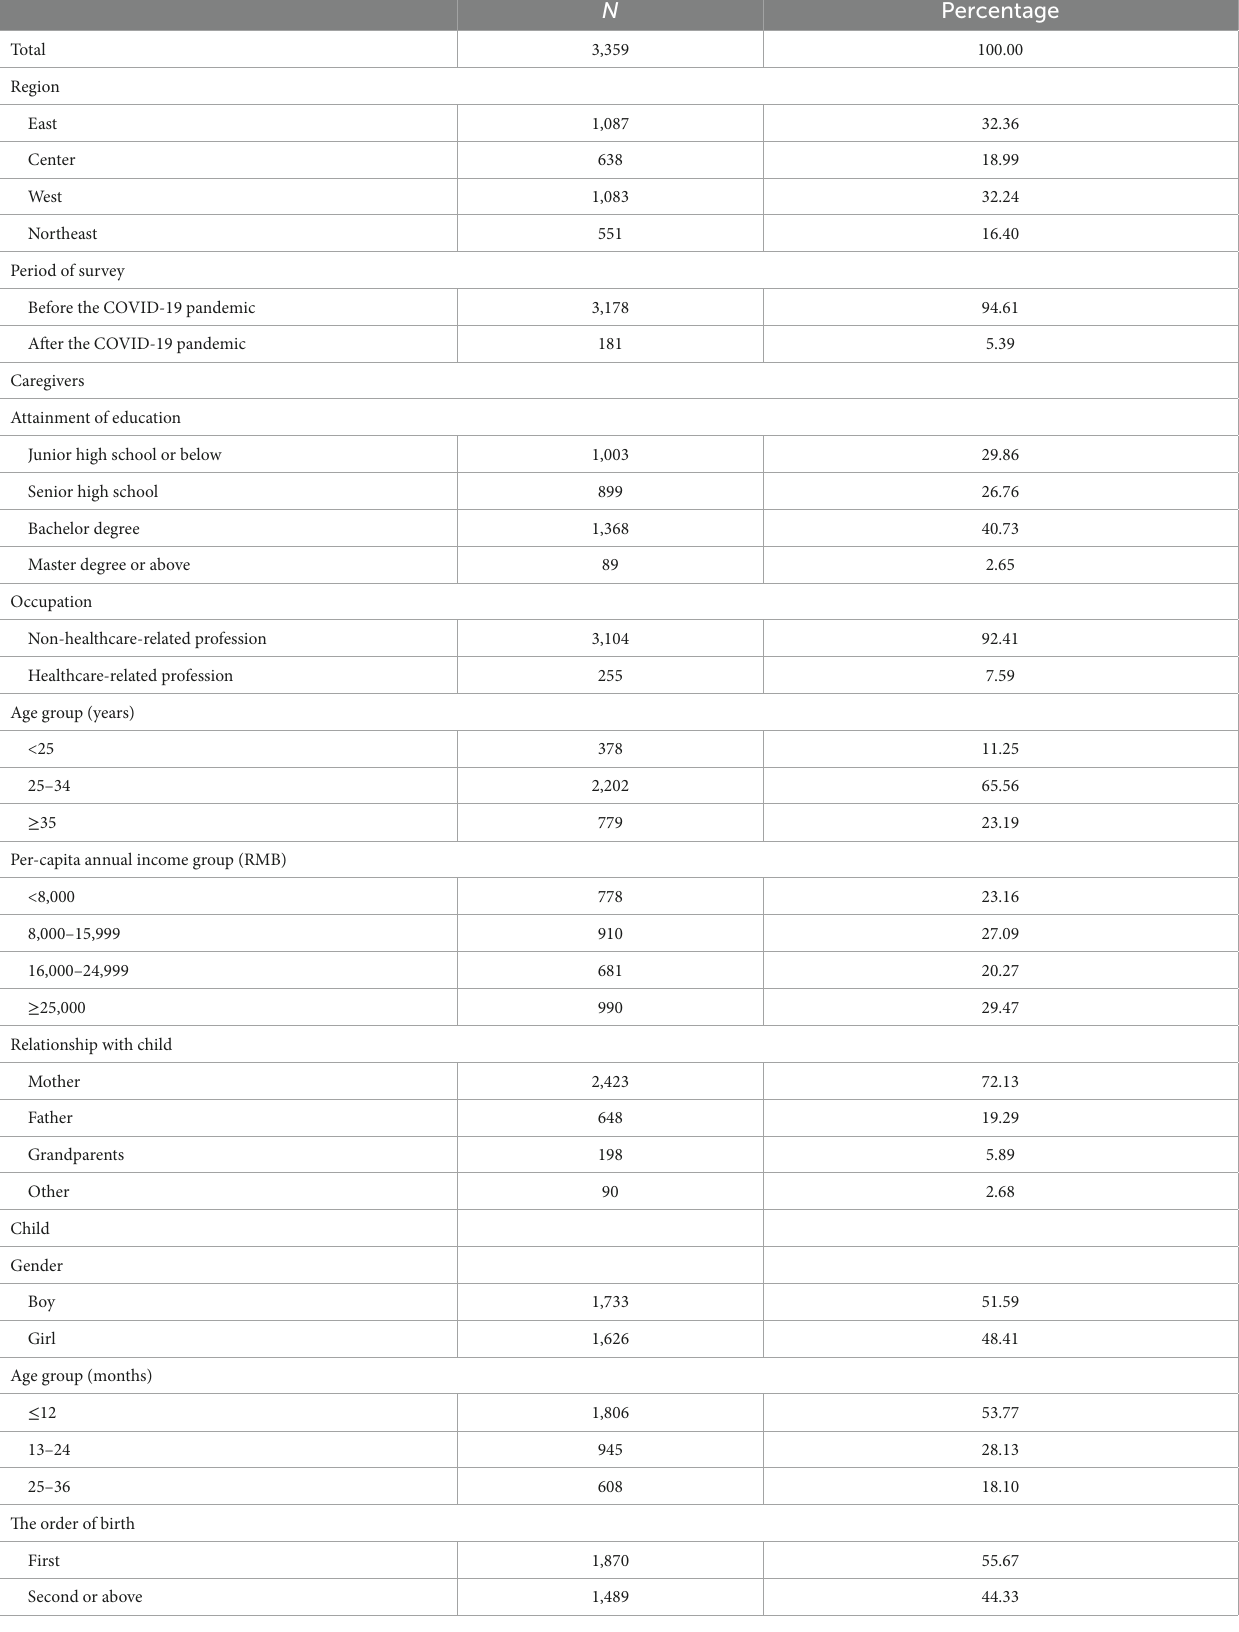
TABLE 1 Demographic characteristics of